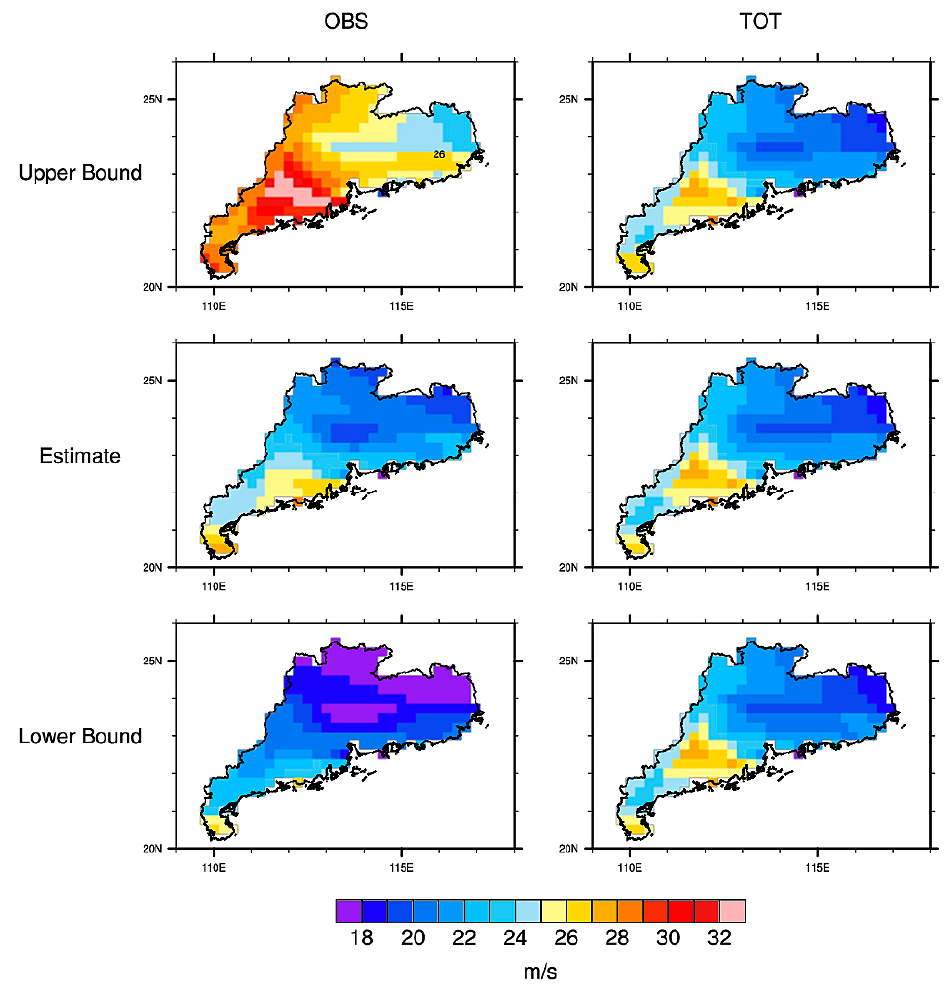
Figure 5. 20-year return level (in m/s) for Guangdong province derived using historical observations (OBS; Left column ), and the TOT event set (TOT; Right column ). The upper bound of the 95% confidence interval, estimate, and lower bound of the 95% confidence interval are shown in top, middle, and bottom rows, respectively.